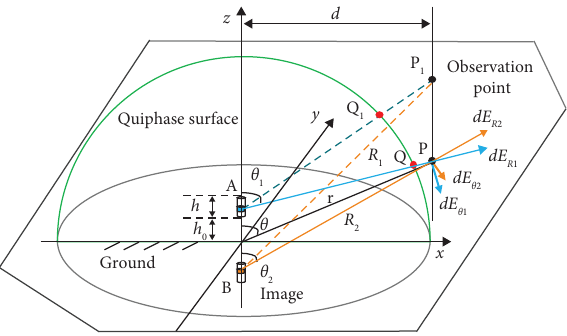
Figure 1: Setup test for radiated emission measurement above